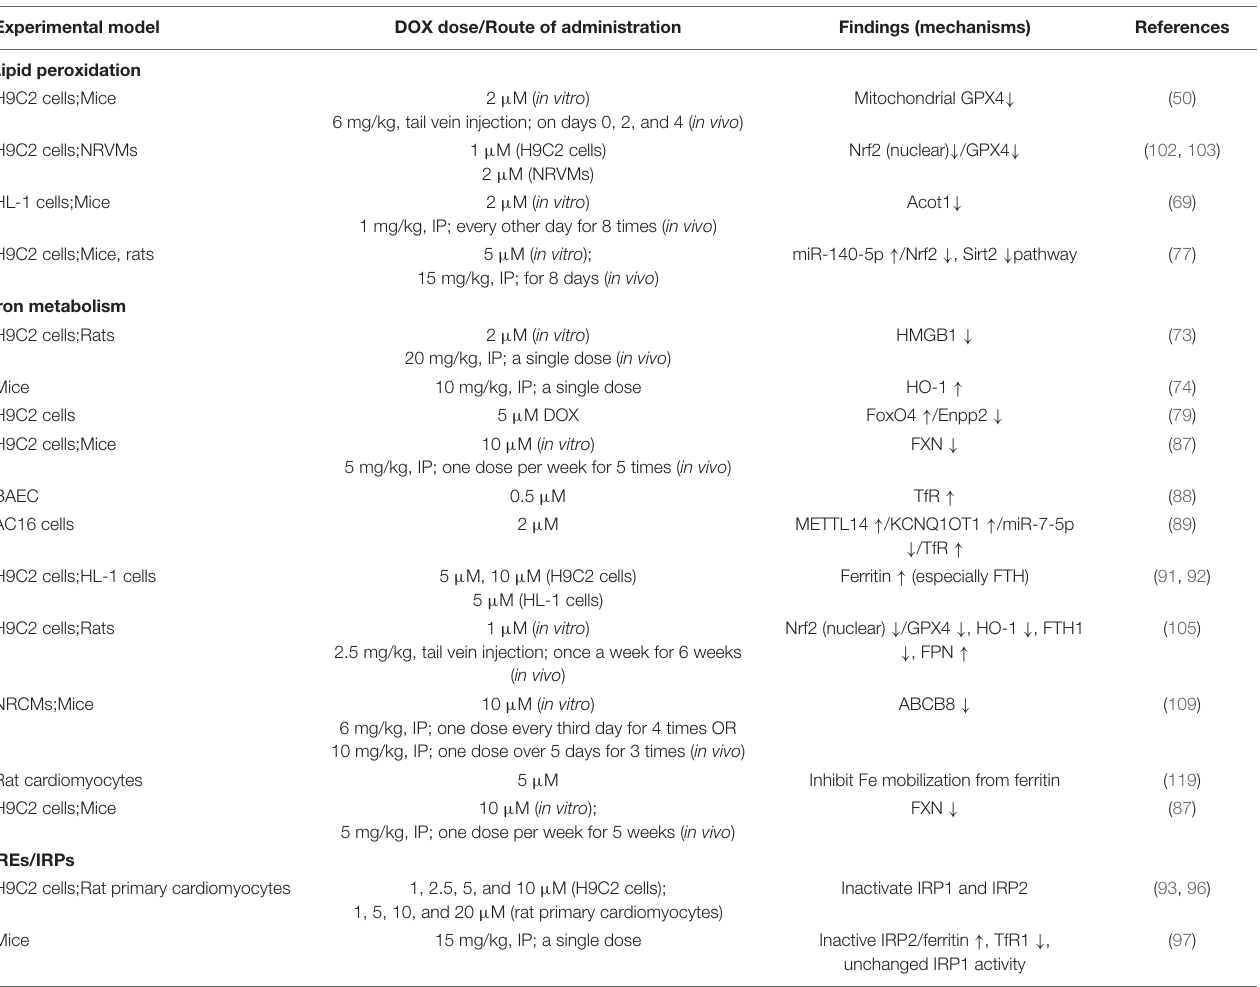
TABLE 1 | The main molecular mechanism of DOX-induced ferroptosis in